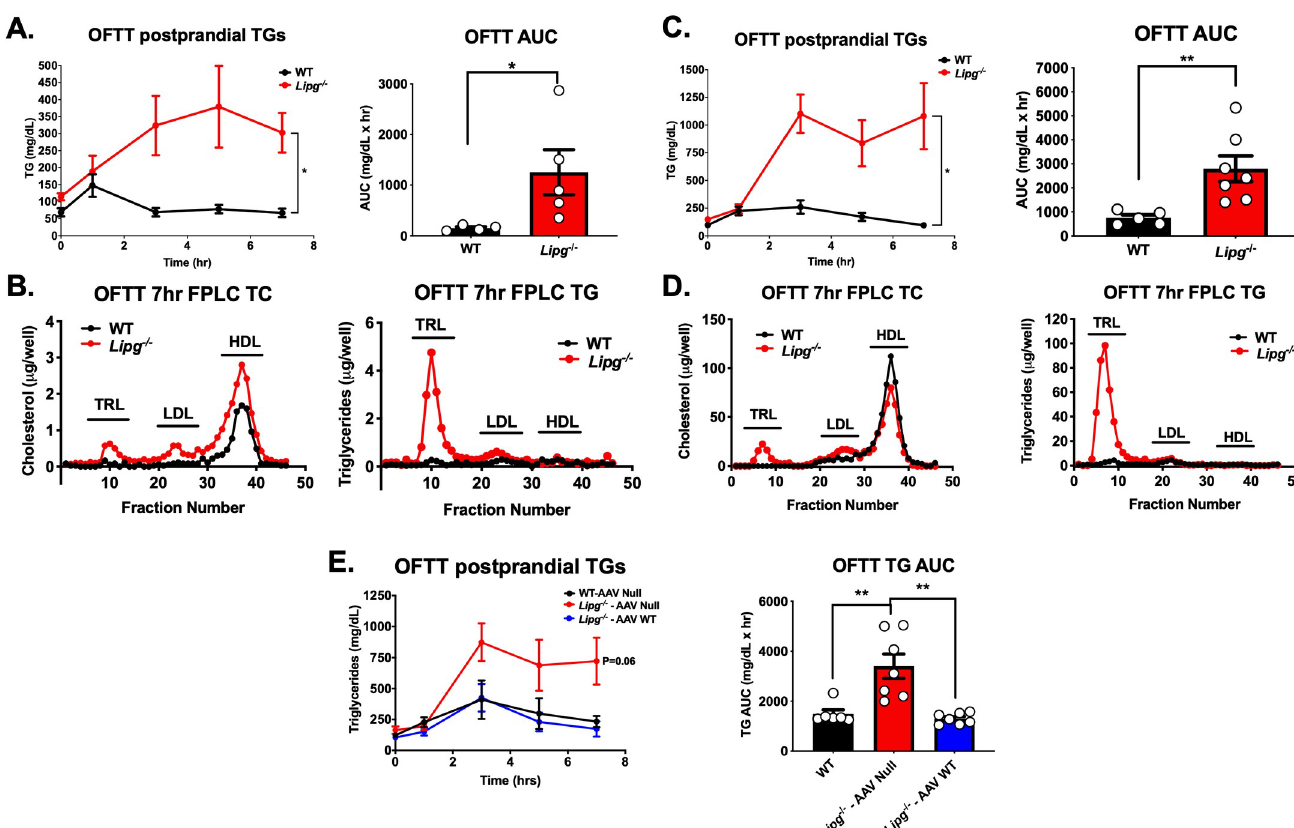
Fig 4. Postprandial chylomicron clearance in Lipg- deficient mice. A. Plasma triglycerides (left) and area under the triglyceride clearance curves (right) in EL WT vs. Lipg -/- mice fed a regular chow diet after overnight fasting and oral fat tolerance testing with olive oil gavage. B. Cholesterol and triglycerides from FPLC fractions of pooled plasma from the 7 hour timepoint from the olive oil gavage in A. C. Plasma triglycerides (left) and area under the triglyceride clearance curves (right) in EL WT vs. Lipg -/- mice fed a high fat diet for 12 weeks after overnight fasting and oral fat tolerance testing with olive oil gavage. D. Cholesterol and triglycerides from FPLC fractions of pooled plasma from the 7-hour timepoint from the olive oil gavage in (C). E. Plasma TGs (left) and areas under the curve (right) after olive oil gavage in EL WT mice treated with Null adeno-associated virus vector (WT-AAV Null), Lipg -/- mice treated with Null vector ( Lipg -/— AAV Null), or Lipg -/- mice treated with AAV expressing murine Lipg directed to the liver ( Lipg -/— AAV WT). A left, C left, E left: P < 0.05, repeated factor 2-way ANOVA, A right, C right, E right: � P < 0.05, �� P < 0.01, student’s unpaired T-test. Data is expressed as mean ± S.E.M.